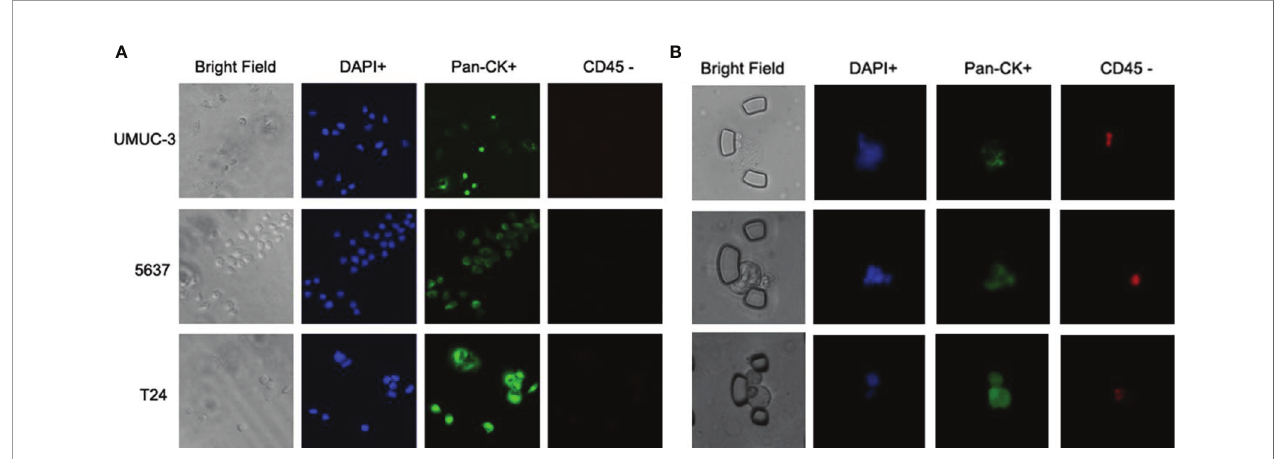
FIGURE 3 | Immuno fl uorescent test on cell lines and validation on the bladder cancer patients. (A) Immuno fl uorescent staining on three bladder cancer cell lines. (B) Captured CTCs from the bladder cancer patients.